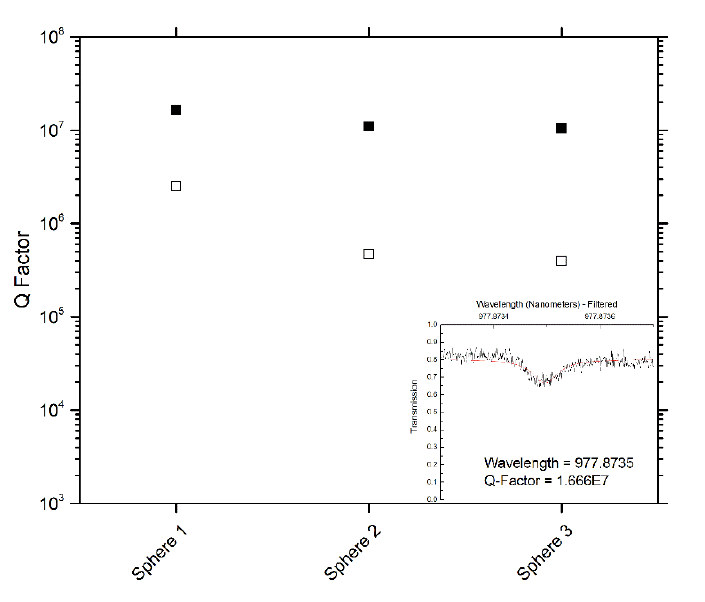
Figure 12. Quality factors of each microresonator used in the sensing study before (solid squares) and after (hollow squares) coating. Inset: a representative resonance (black line—data, red line—Lorentzian fit), showing a high quality factor device.